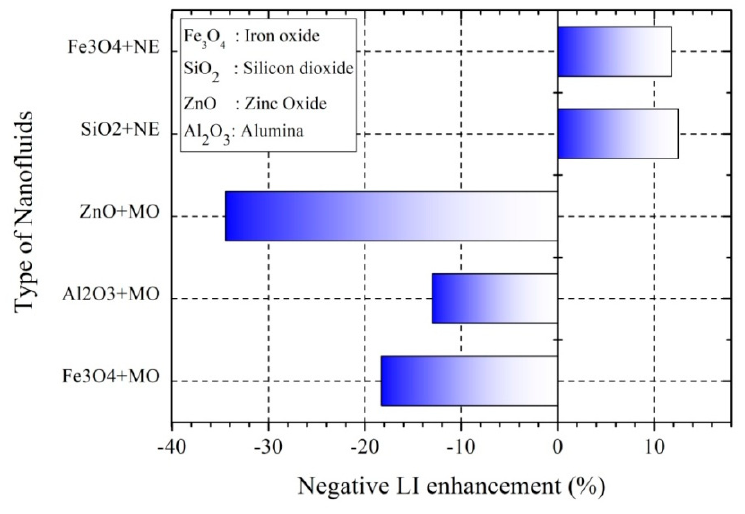
Figure 2. Reports on the LI performance of nanofluids